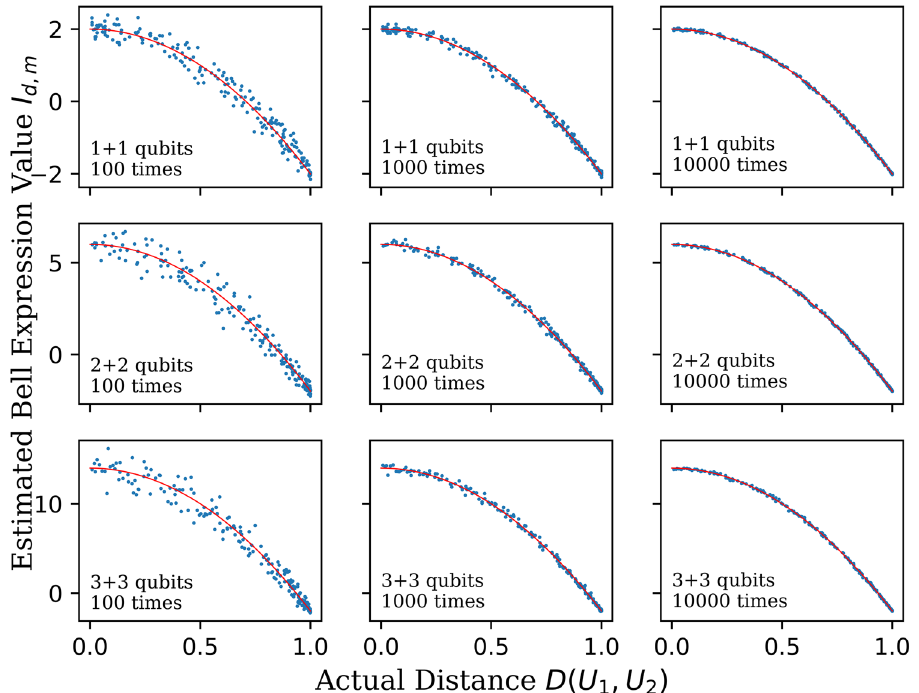
Fig. 3 Determining the distance D ( U 1 , U 2 ) based on Theorem 3. Here U 1 and U 2 are randomly sampled, and m = 2. Every blue point corresponds to picking up a speci fi c pair of U 1 and U 2 and then running the Monte Carlo process described in section The analysis of computational cost, where s = 100, 1000, 10,000, respectively. We sample U 1 and U 2 of 1, 2, or 3 qubits, which means the experiments are performed on two 2, 4, or 6-qubit circuits. The red solid line is given by Theorem